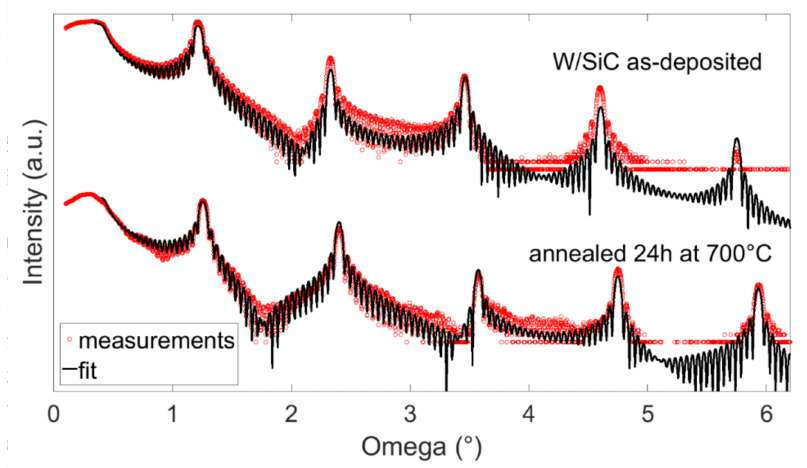
Figure 7. SAXRD experimental data and fits of the same W/SiC multilayer before and after anneal at 700 ◦ C for 24